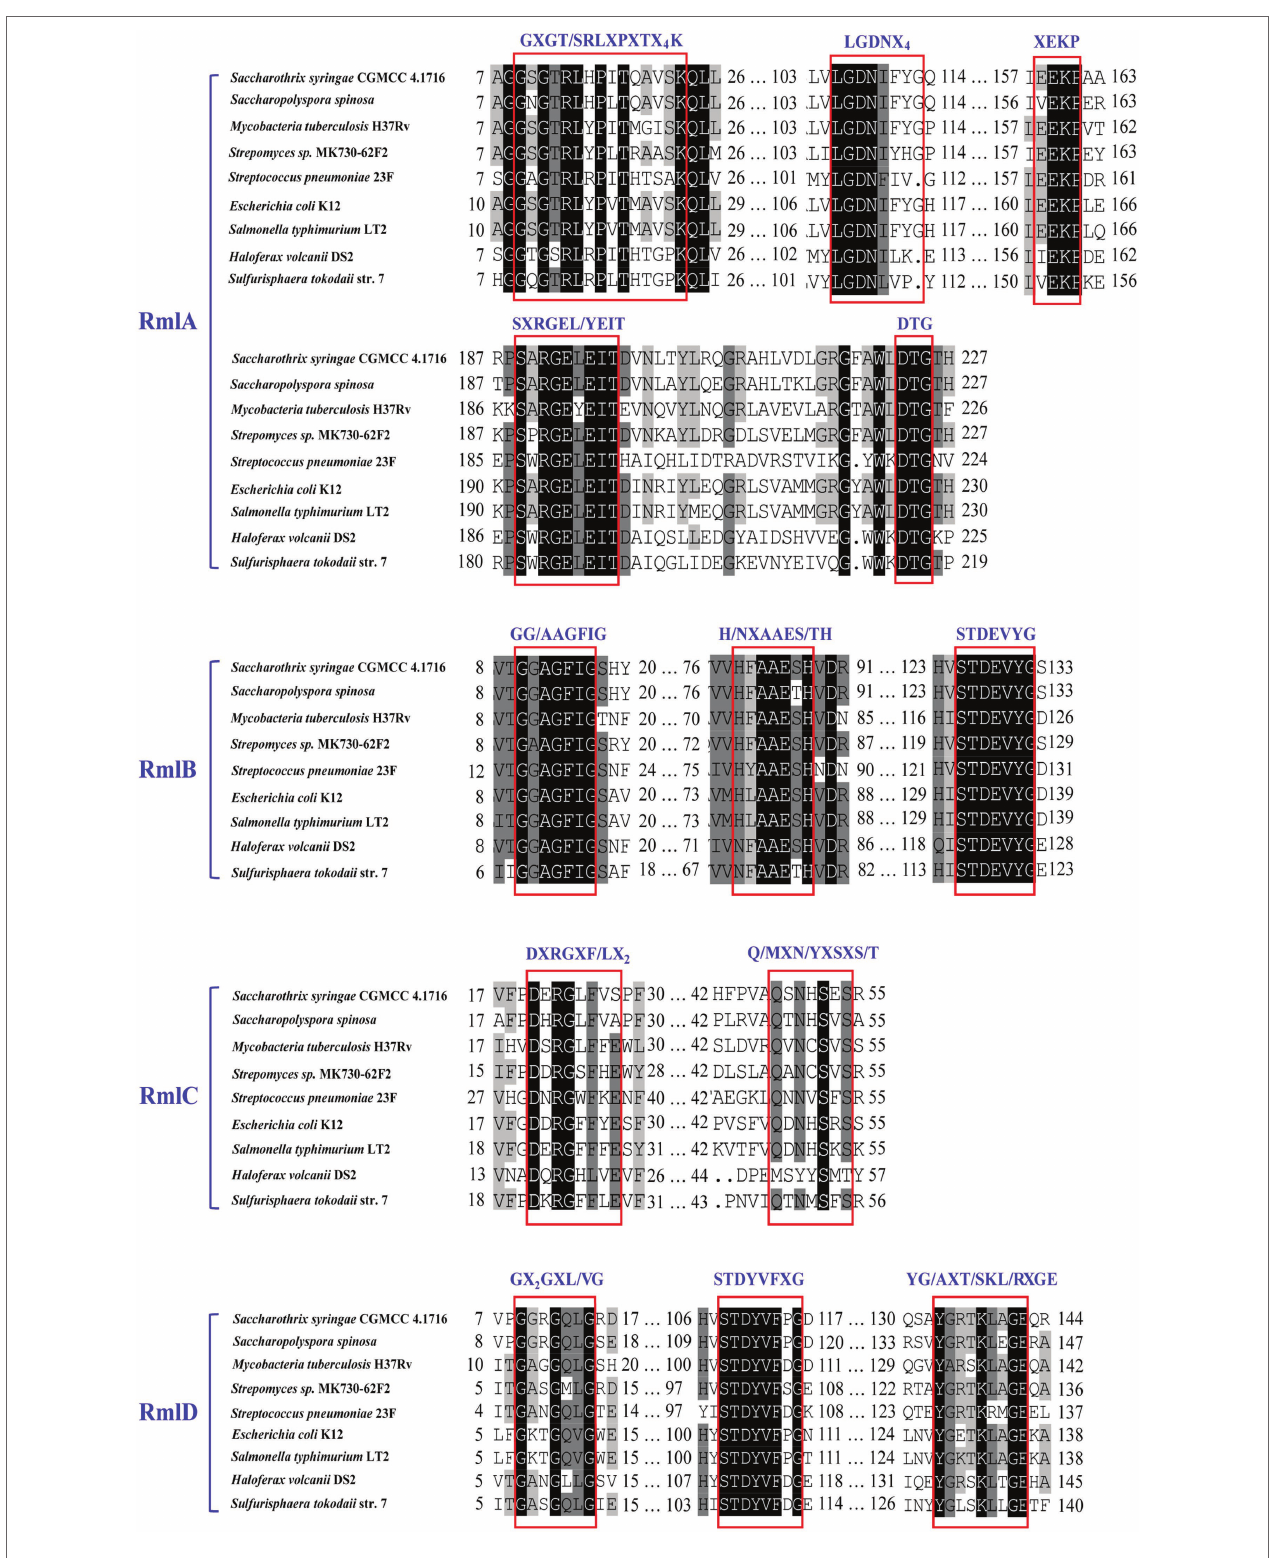
FIGURE 3 | Multiple alignments of the partial amino acid sequences of RmlABCD. The sequences for alignment were from Saccharothrix syringae CGMCC 4.1716, Saccharopolyspora spinosa , Mycobacteria tuberculosis H37Rv, Streptomyces sp. MK730-62F, Streptococcus pneumoniae 23F, E. coli K12, Salmonella typhimurium LT2, Haloferax volcani DS2, and Sulfurisphaera tokodaii str. 7. The critical motifs are boxed and